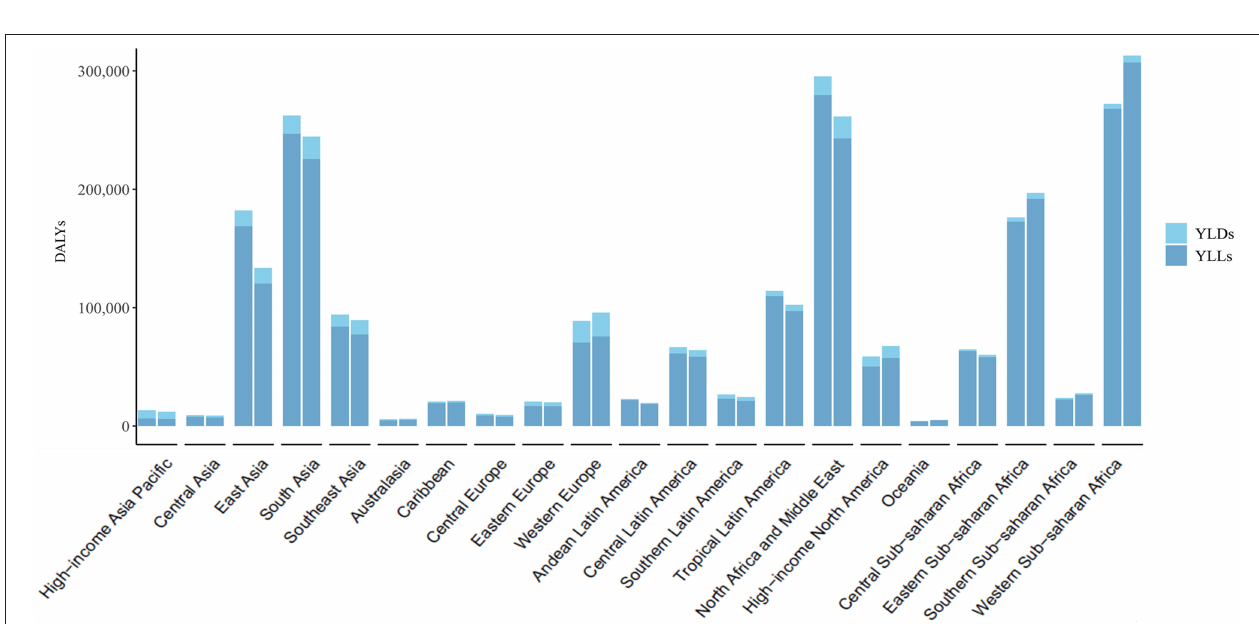
FIGURE 2 | The DALYs, YLDs, and YLLs of Down syndrome at a regional level. The left column in each group is the data in 2010 and the right column in 2019. DALYs, disability-adjusted life years; YLDs, years lived with disability; YLLs, years of life lost.